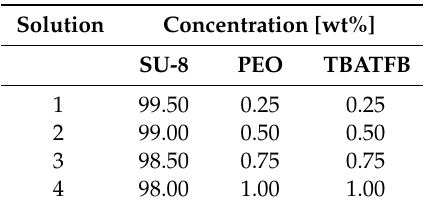
Table 2. Prepared polymer